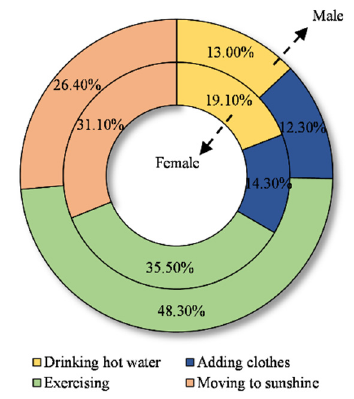
Figure 14. Comparison of preferred methods of thermal